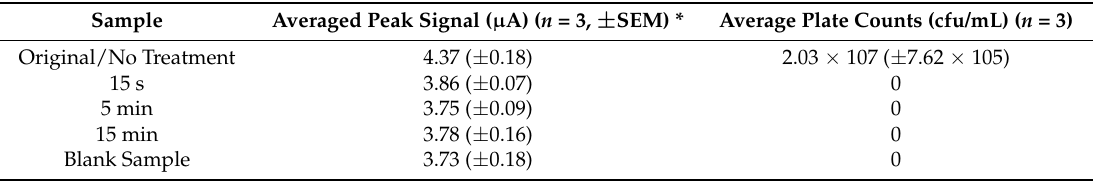
Table 1. TiO 2 -based electrocatalytic reactor-treated E. coli . O157:H7 electrochemical current density signal and plate